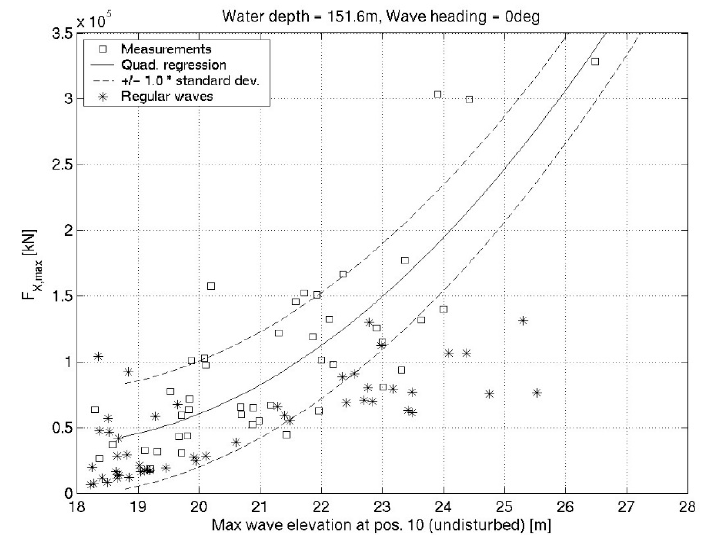
Figure 3. Correlation plot of measured horizontal deck force vs. incident crest. Example from [8].